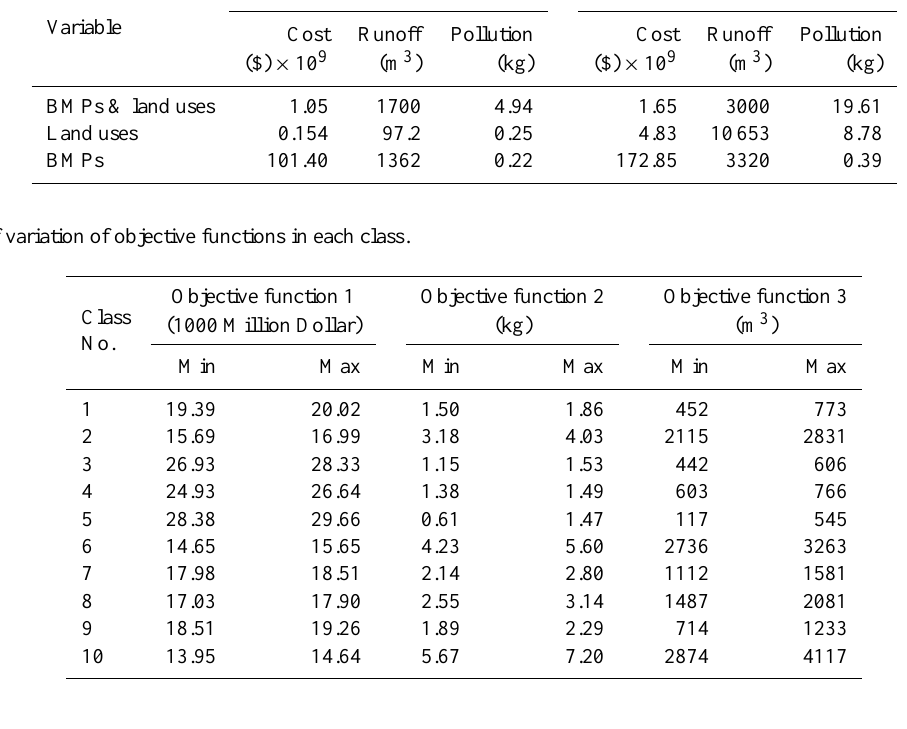
Table 8. Number of flooded nodes in each